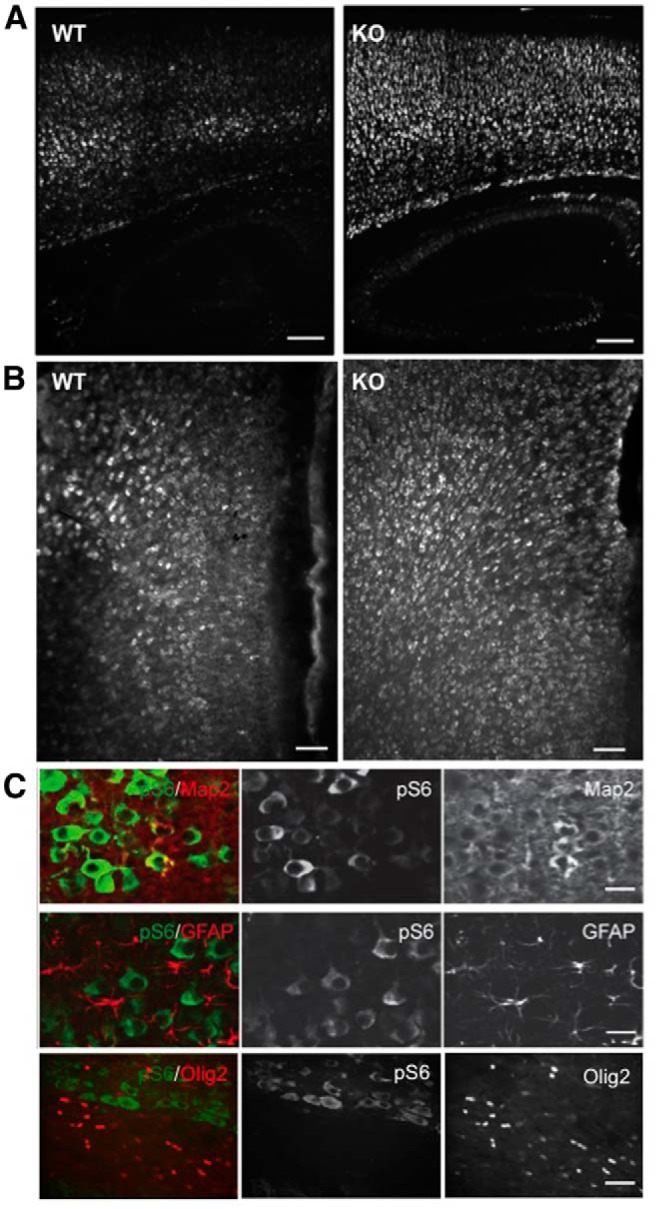
Neuron-specific activation of mTORC1 in the KO NEX-Tsc2 forebrain at P10. A, Low-magnification images of the somatosensory cortex and hippocampus obtained from sagittal sections of WT and KO NEX-Tsc2 brains stained with pS6 antibodies. B, Low-magnification images of the anterior cingulate cortex obtained from coronal sections of WT and KO NEX-Tsc2 brains stained with pS6 antibodies. The pS6 signal is stronger in all areas of the KO forebrain compared with the WT. C, High-magnification confocal images of KO neocortical sections double labeled with pS6, and the indicated cell marker antibodies show that the pS6 signal colocalizes with the neuronal marker Map2, but not with the astrocyte marker GFAP or the oligodendrocyte marker Olig2. Scale bars: A, 200 µm; B, 100 µm; C, 20 µm.